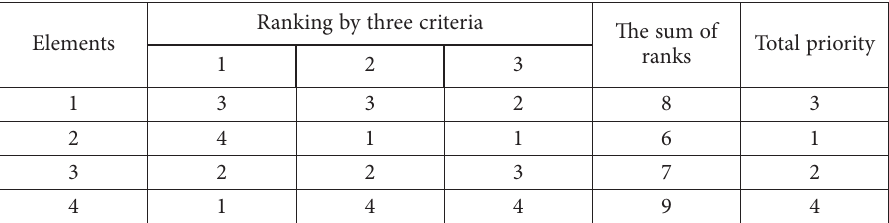
Ranking by three criteria The sum of